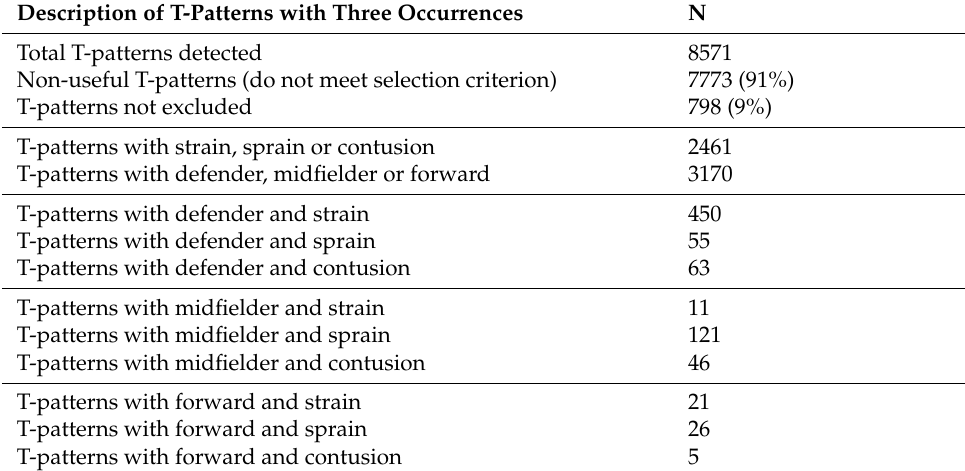
Table 2. Analysis of the selective search for